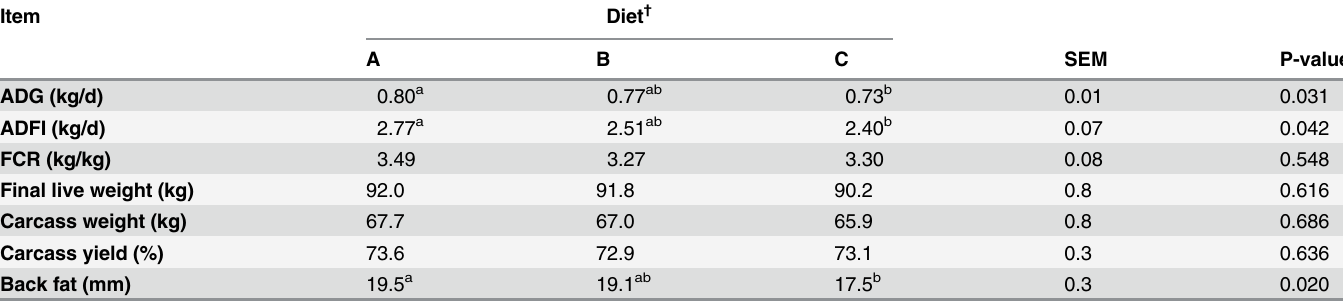
Table 4. Effect of dietary energy sources on the growth performance and carcass traits of finishing